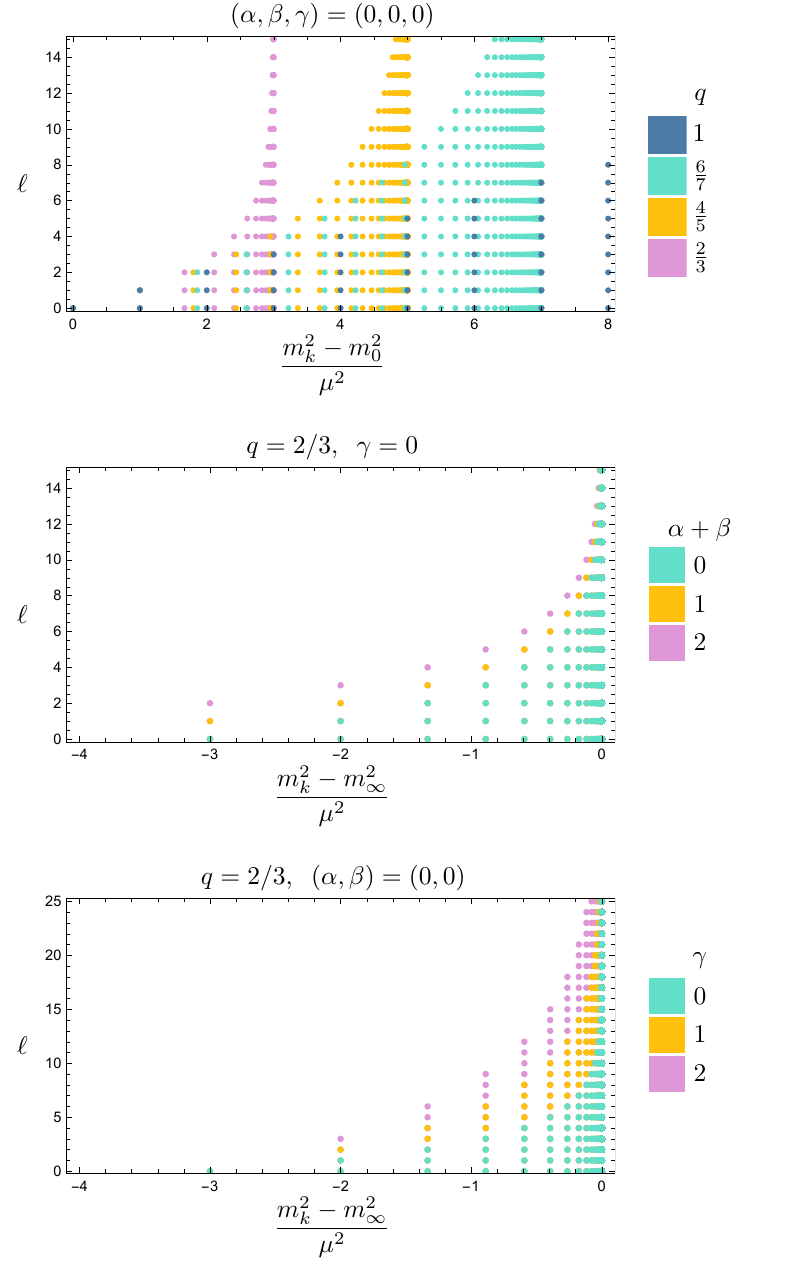
Figure 1 . Chew-Frautschi plots depicting the spin ‘ and mass squared m 2 for the modes exchanged k at the k th level in our amplitudes. Top: for ( α, β, γ ) = (0 , 0 , 0) and various values of q , we see how the logarithmic Regge trajectories and accumulation points of the original Coon amplitude ( q < 1 ) interpolate into the linear trajectories and unbounded spectrum of the Veneziano amplitude ( q = 1 ). Bottom left: for q = 2 / 3 , different values of α + β add linearly to ‘ max ( k ) , though α and β enter independently in the actual amplitude. Bottom right: for q = 2 / 3 , different values of γ add multiplicatively to ‘ max ( k ) . Note that the colored dots are overlayed, so it should be understood that the states represented by pink, yellow, and teal have spins ranging from ‘ max ( k ) down to 0 and all first appear at m 2 0